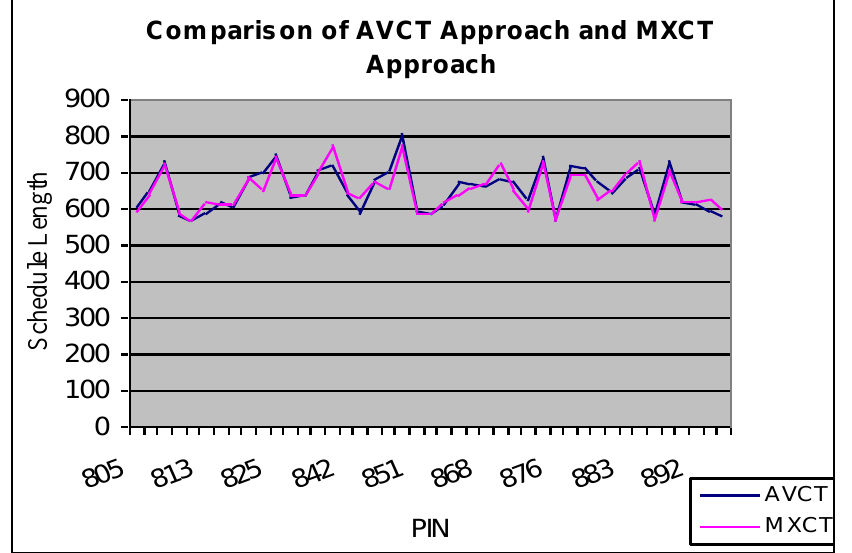
Figure 8. Variations in schedule length obtained from AVCT approach and MXCT approach.